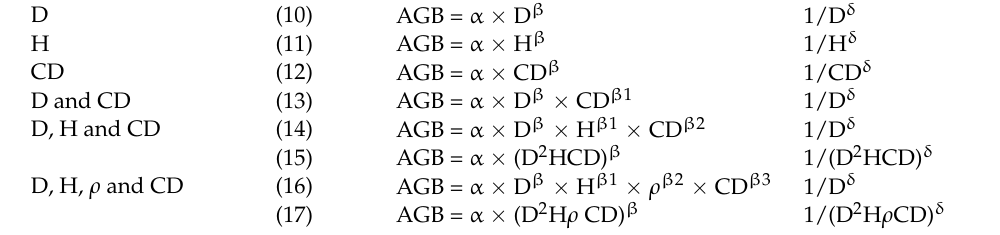
Model set 2a: Compound predictor variables including D, H, ρ and CD, n = 40